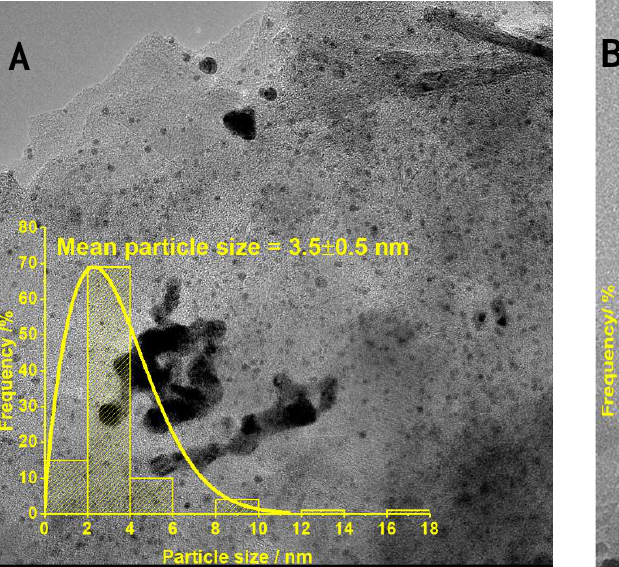
Figure 1. X-ray diffraction pattern for (A) Pd 1 Co 1 /CNT, (B) Pd/N-rGO without hydrogen treatment, (C) Pd/N-rGO, (D) Pd 1 Co 1 /N-rGO, (E) PdCo 3 /N-rGO, and (F) Pd 3 Co/N-rGO. Table 1. XRD and TEM analyses of the as-prepared catalysts. A B